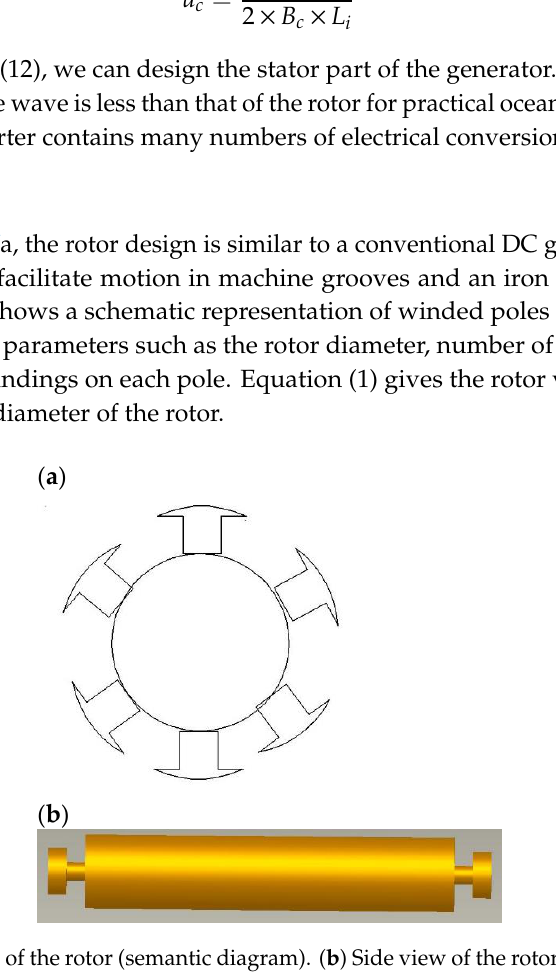
Figure 7. ( a ) Front view of the rotor (semantic diagram). ( b ) Side view of the rotor (solid state